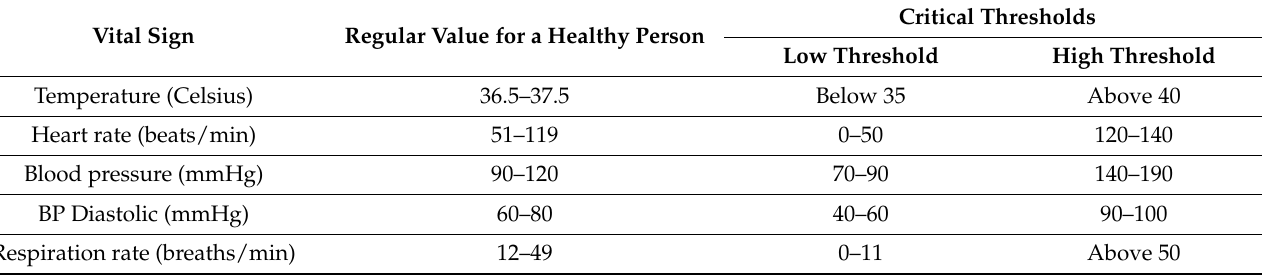
Table 1. Threshold values for each vital